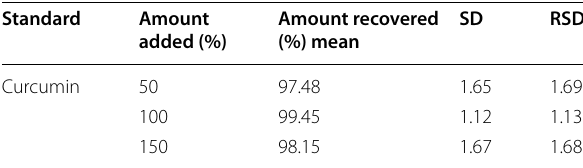
Table 3 Recovery analysis of